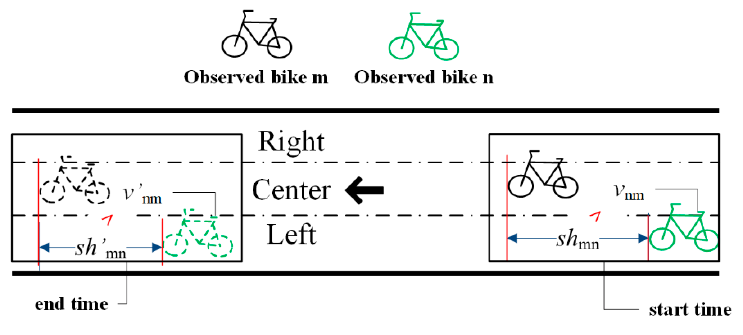
Figure 2. Indication of a Bicycle in Free Flow State.